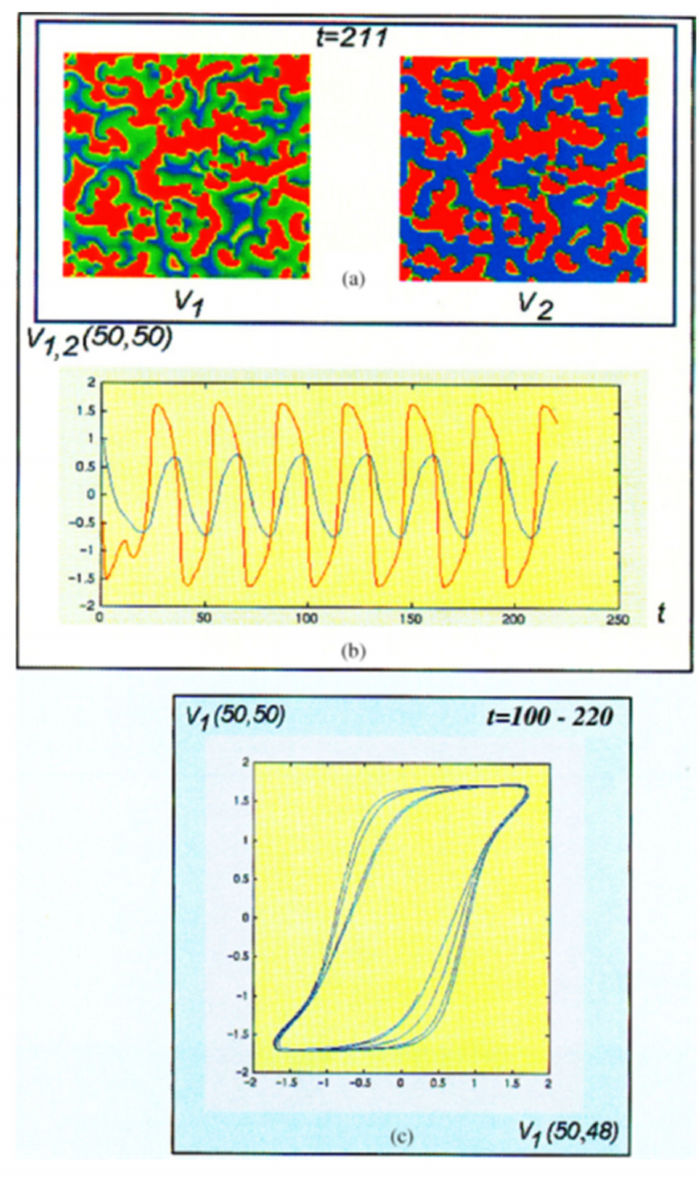
Figure 6. Dynamic patterns of the Gierer–Meinhardt system. ( a ) snapshot of the dynamic pattern; ( b ) time evolution of the state variables; ( c ) projection of the high-dimensional